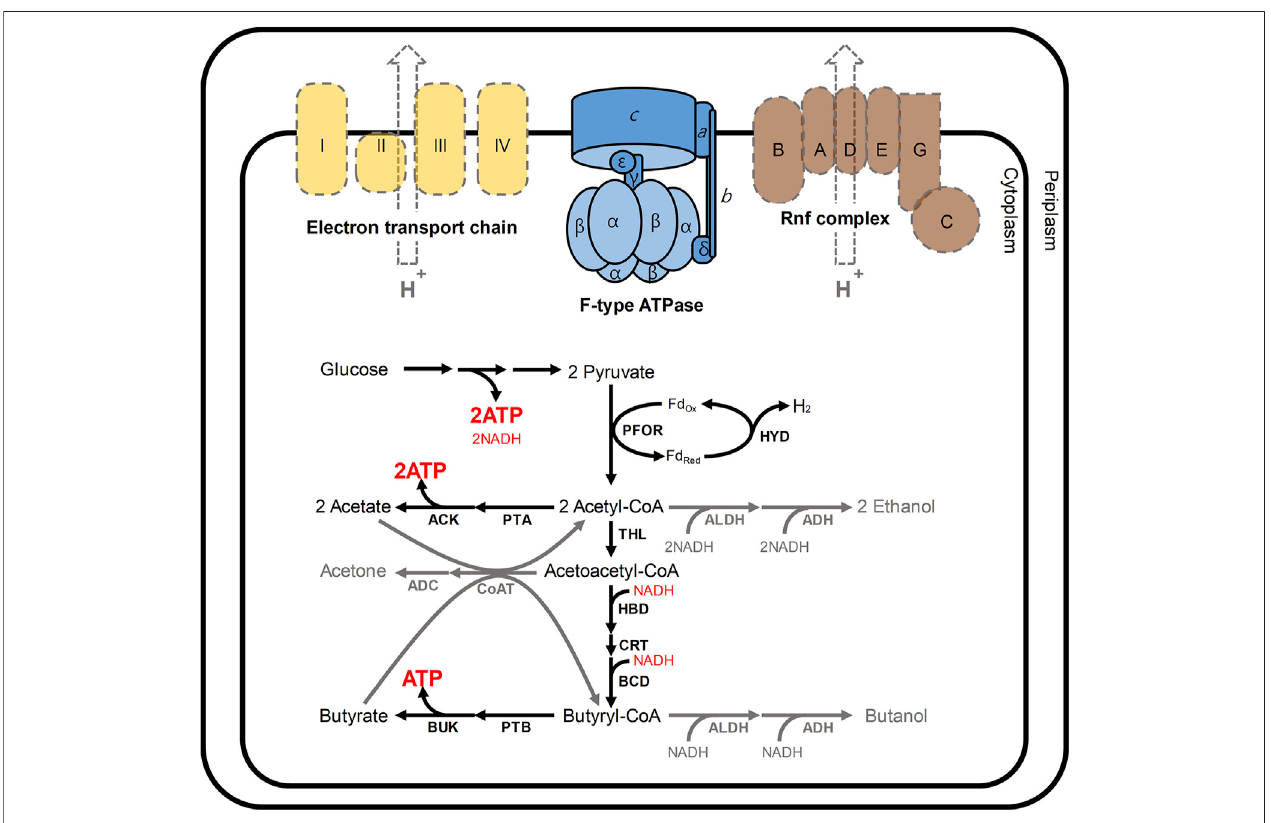
FIGURE1| Schematic presentation oftheenergy and redox metabolism in C. acetobutylicum. In C.acetobutylicum , F-type ATPase isencoded bythe atp operon ( atp IBEFHAGDC). In general, F-type ATPases require the proton motive force to produce ATP; however, neither the electron transport chain (yellow) nor Rnf complex (brown) has been reported in C. acetobutylicum (Tremblay et al., 2012). The Rnf complex is commonly reported in other clostridia such as Clostridium beijerinkii, Clostridiumsaccharobutylicum and Clostridiumsaccharoperbutylacetonicum ,butitisusualthattheRnfisnotfoundin C.acetobutylicum (Poehleinetal.,2017).In this situation, meanwhile, 2 mol of ATP are produced from a glucose through glycolysis. During the initial growth phase (namely, acidogenic phase), additional ATP is produced through the routes for the production of acetate and butyrate. At that time, NADH could be re-oxidized via two routes: 1) a cascade reaction for butyrate formation involving 3-hydroxybutyryl-CoA dehydrogenase (HBD) and butyryl-CoA dehydrogenase (BCD); 2) hydrogen production reaction catalyzed by hydrogenase (HYD)coupled withferredoxinoxidoreductase(PFOR).Duringsolventogenicphase(grayarrows),thefunctionofhydrogenaseisturned-off,andNAD + isregeneratedby 4 (HBD, BCD, ALDH, and ADH) and 2 (ALDH and ADH) dehydrogenases for butanol and ethanol biosynthesis, respectively. Abbreviations: ACK, acetate kinase; ADC, acetoacetate decarboxylase; ADH, alcohol dehydrogenase; ALDH, aldehyde dehydrogenase; BUK, butyrate kinase, CoAT, CoA transferase; CRT, crotonase; THL, thiolase; PTA, phosphotransacetylase; and PTB, phosphotransbutyrylase.